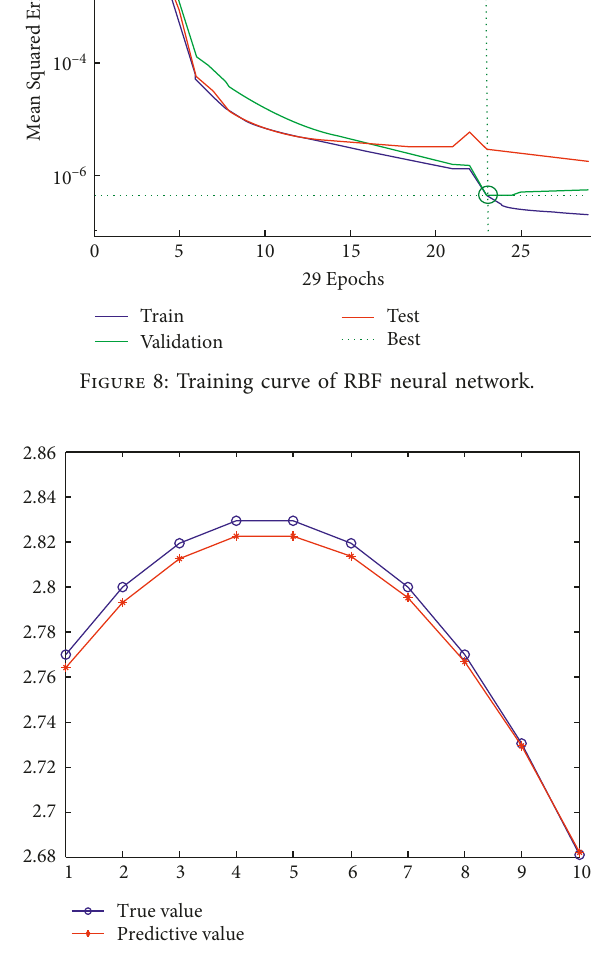
Figure 9: Comparison of RBF-predicted and real